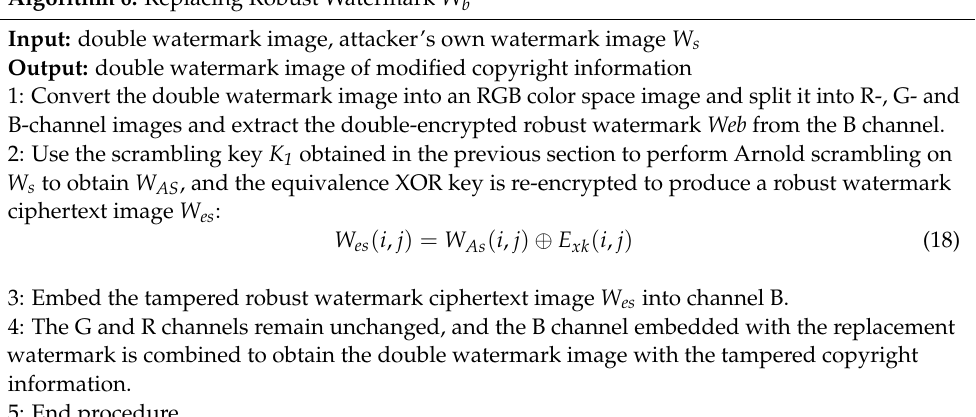
Algorithm 6: Replacing Robust Watermark W